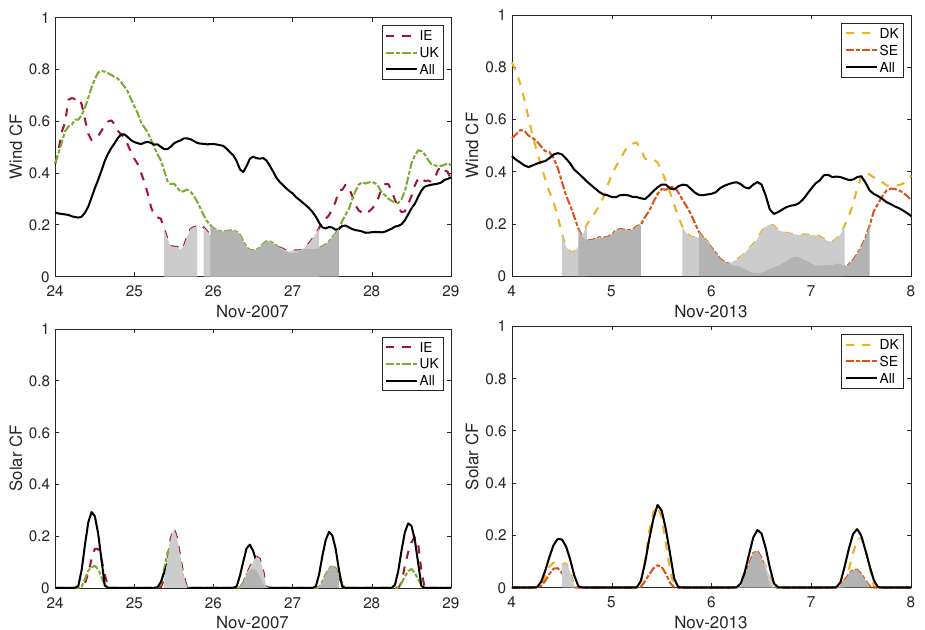
Figure 9. Time series of wind capacity factor ( top panel) and solar capacity ( bottom panel) during two cases of Dunkelflaute, which occurred in Ireland (IE), the UK ( left panel), Denmark (DK), and Sweden (SE, right panel), respectively. The wind and solar CF are shown for the individual countries and an interconnected system of eleven countries (labeled as ‘All’). The Dunkelflaute periods are demarcated by shaded gray regions. Different shades correspond to different